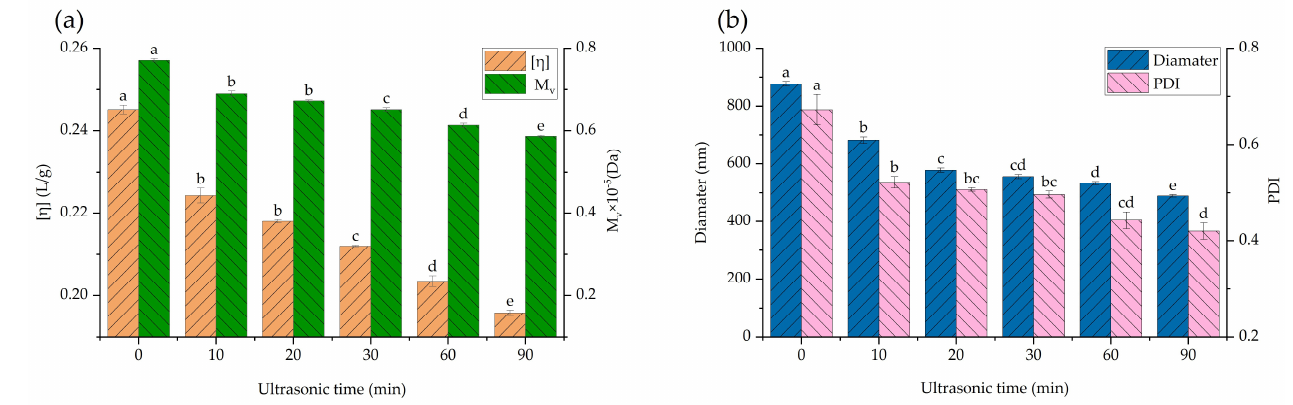
Figure 1. ( a ) Intrinsic viscosity and M V of native SBP and its ultrasonic degradation products. ( b ) The particle size and PDI of SBP and its ultrasonic degradation products. Different letters a–f indicate significant differences ( p < 0.05).